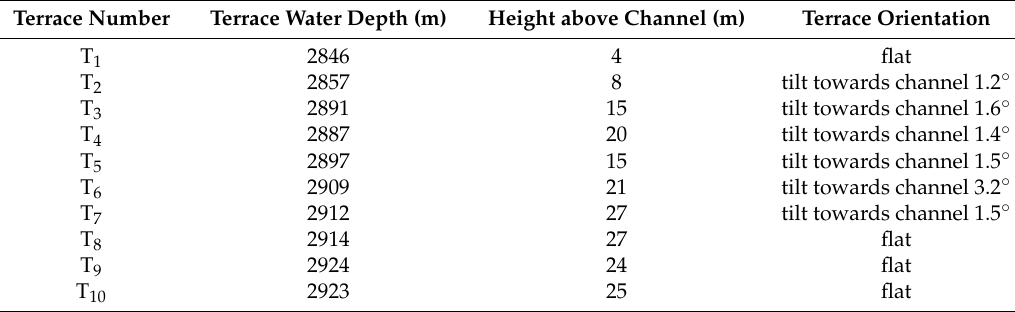
Table 1. LSinR terrace water depths and heights above channel